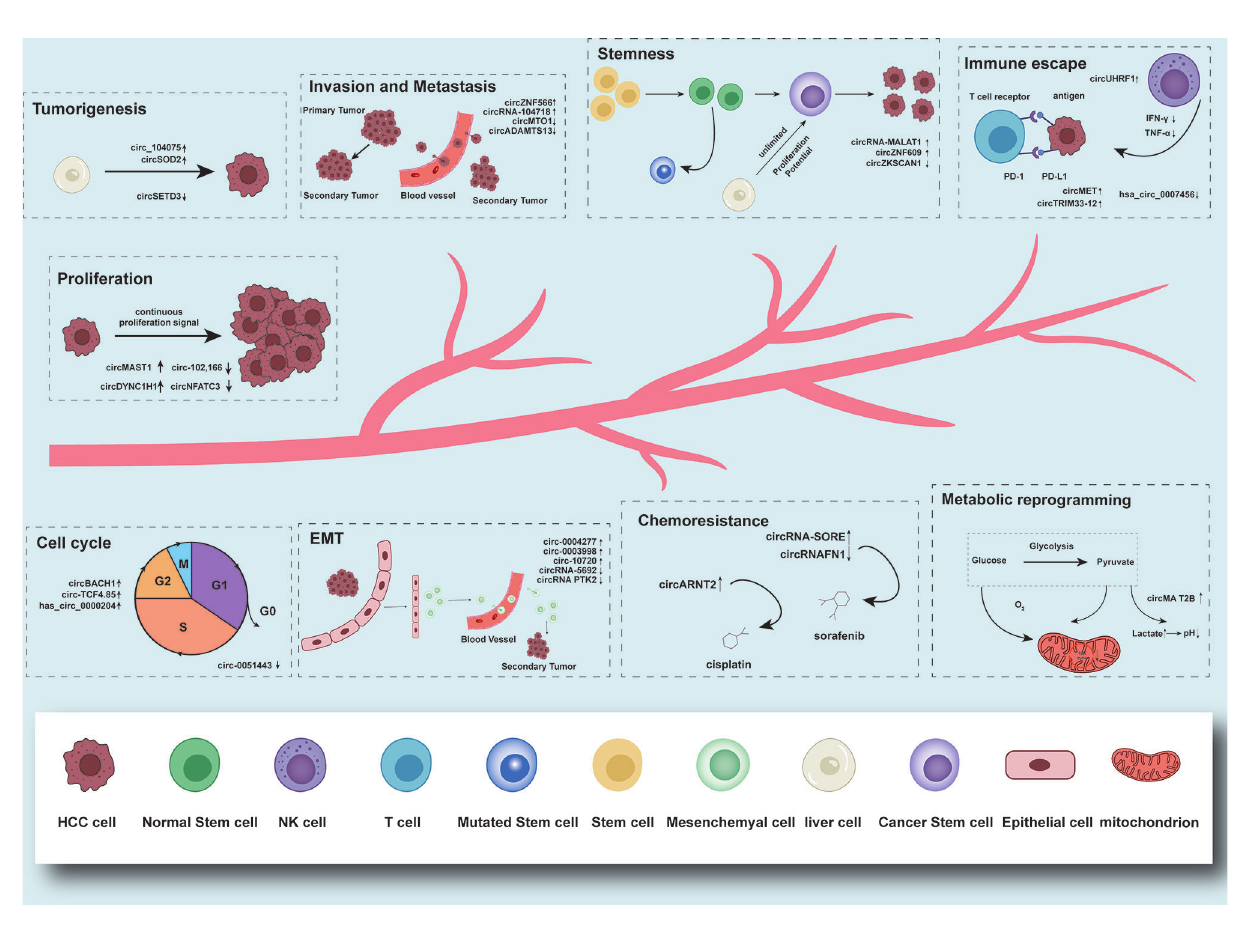
FIGURE 2 | Functions and brief mechanism of circRNAs in HCC tumorigenesis and progression. Aberrantly expressed circRNAs in HCC can participate in the mediation of tumorigenesis, cell proliferation and apoptosis, invasion and metastasis, cell cycle, EMT, immune escape, drug resistance, metabolic reprogramming, and